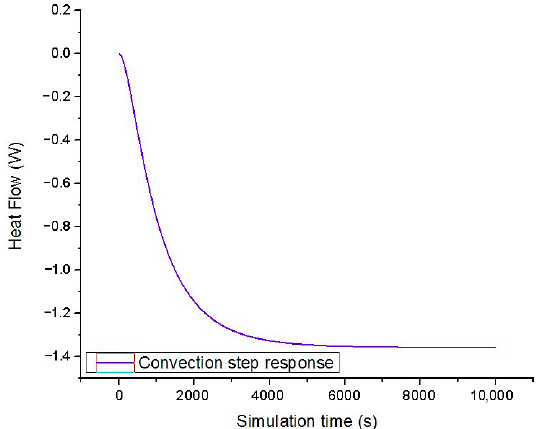
Figure 17. Nodal reaction heat flow of the convection boundary condition.